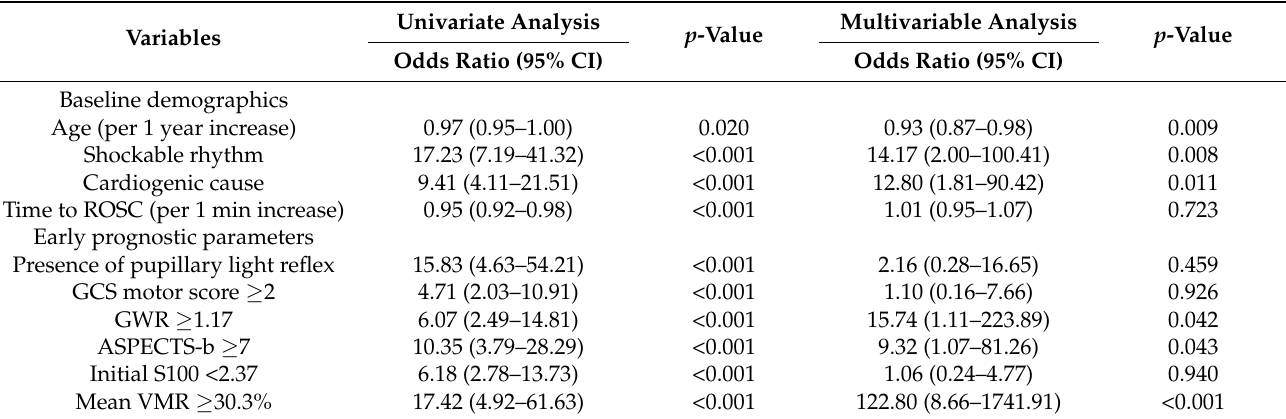
Table 2. Logistic regression analyses for predicting good CPC within 72 h.